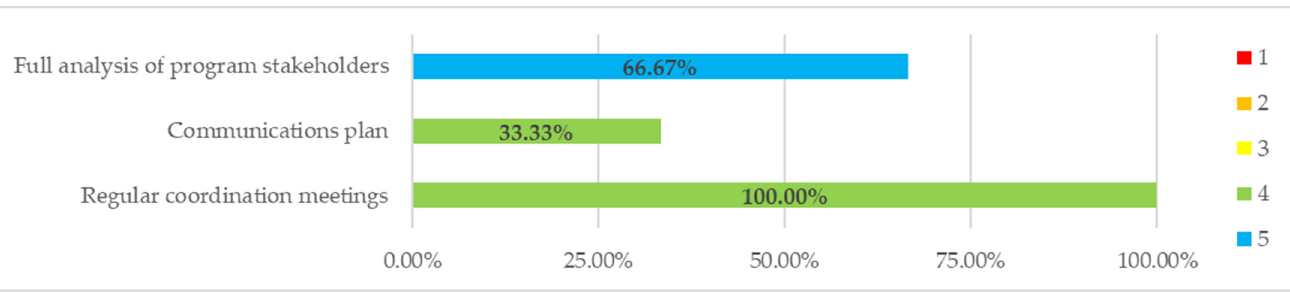
Figure 11. Evaluation of the effectiveness of the methods, techniques and tools used for the communication control pro- cess. Source: own elab.